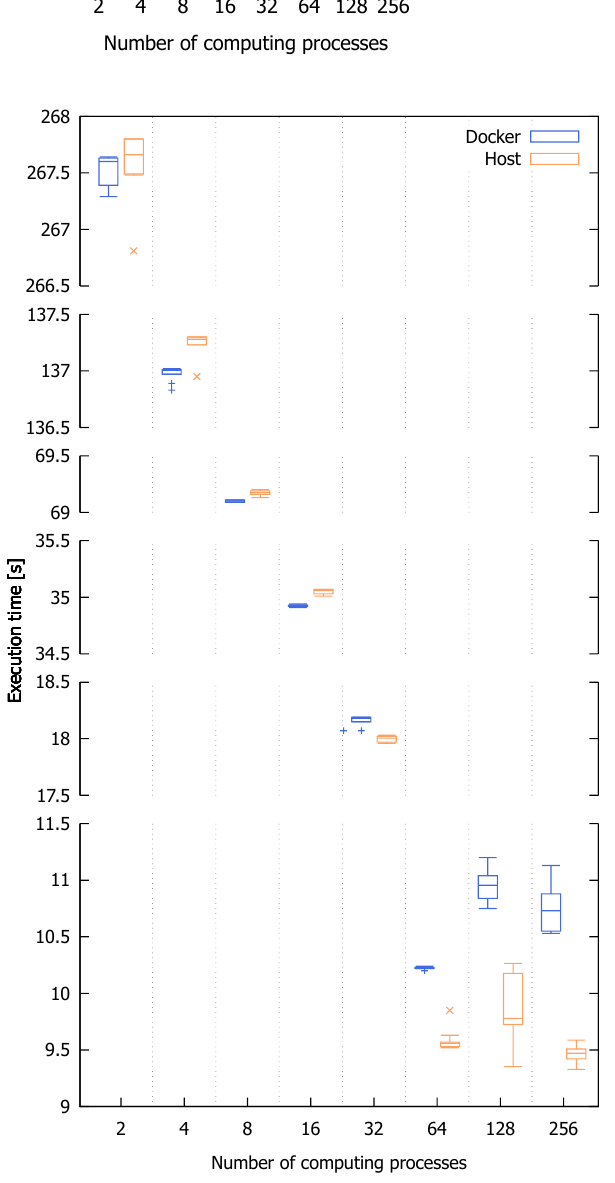
Figure 1. Execution times for DAC, -O2 compilation flag; boxplot notation: medians, Q1 and Q3, max(Q1 − 1.5IQR, minimum) and min(Q3+1.5IQR, maximum) as well as potential outliers (+ for Docker, x for